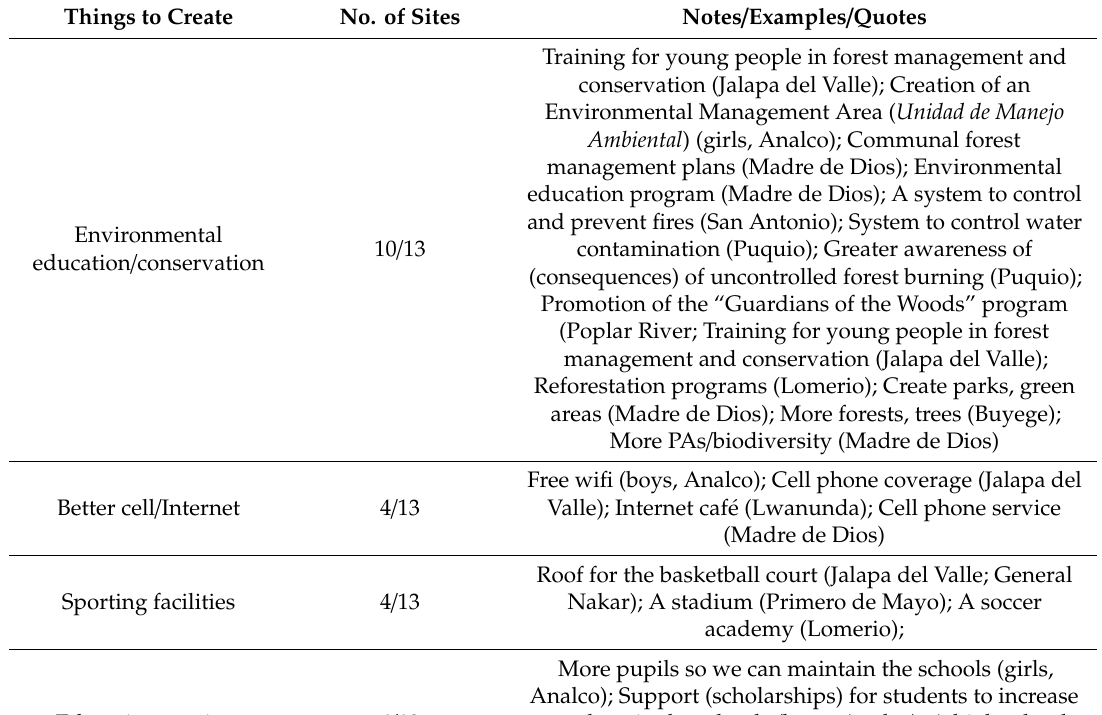
Table 4. What youth want to see in their communities (aggregate results from 13